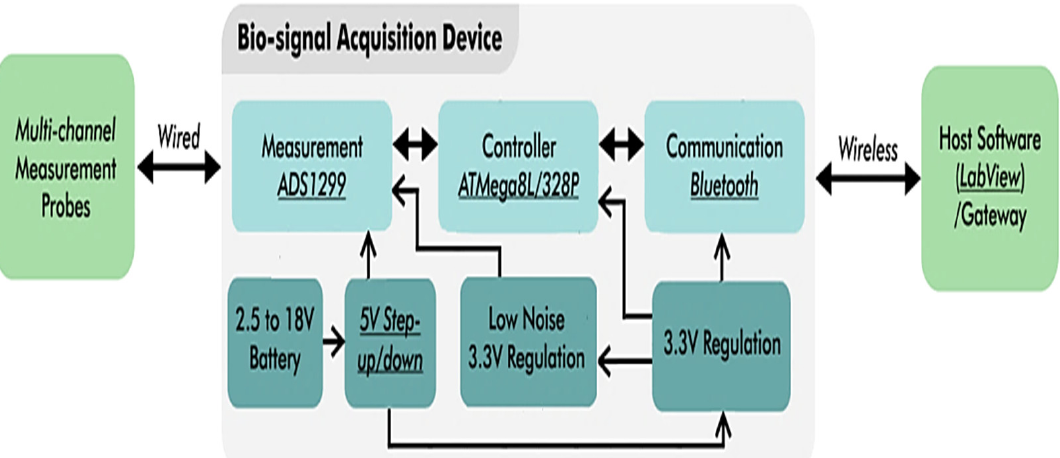
Figure 8. Device architecture proposed in [118] (Reproduced with permission from [118], IEEE, 2017).